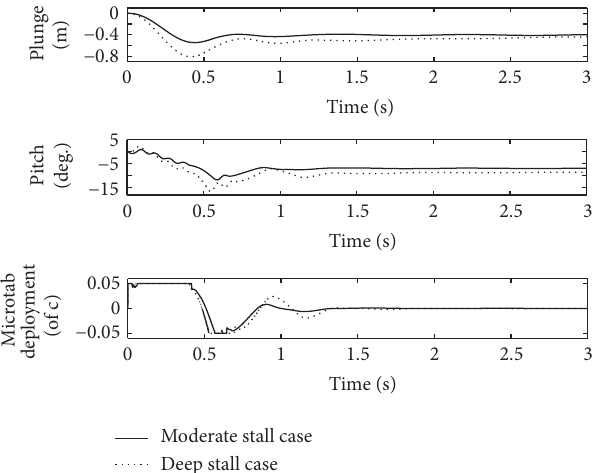
Figure 16: Control results of the closed-loop system for moder- ate/deep stall flutter